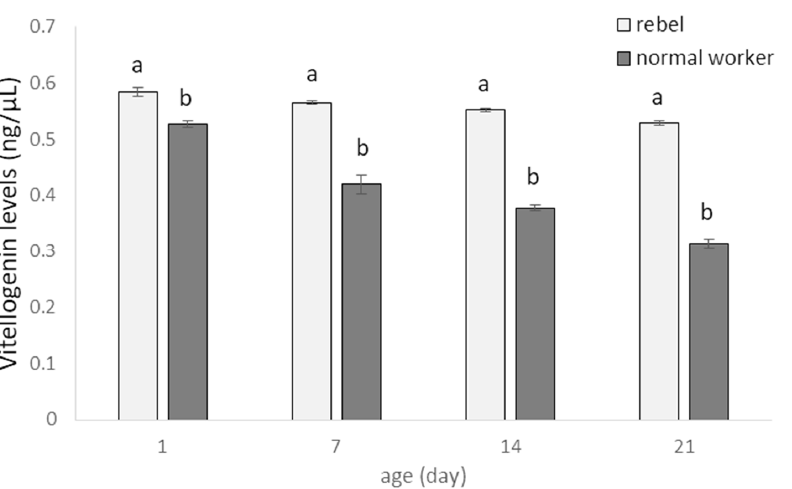
Figure 4. Vitellogenin levels (mean ± SD) in hemolymph of normal workers and rebels. Lowercase letters indicate significant differences between averages for the rebels and normal workers within a specific age with p < 0.01; No. of rebels = 60; no. of normal workers = 60. The numbers of oenocytes in the fat body of all segments (the fourth, fifth, sixth, and seventh tergite segments and in the sternite) increased with age of the workers and was always higher in rebels (Figure 5; Two-way ANOVA with multiple comparison testing using the post hoc Tukey HSD test; for the third tergite: age F (3,232) = 1080.2; p < 0.0001; castes/sub-caste F (1,232) = 25,095.0; p < 0.0001, post-hoc for each group max. p < 0.0001; castes/sub-caste*age F (2,232) = 1080.2, p < 0,0001, post-hoc for each group max. p = 0.01; for the fourth tergite: age F (3,232) = 28,103.0; p < 0,0001; castes/sub-caste F (1,232) = 27,218.0; p < 0.0001; post-hoc for each group max. p < 0.0001; castes/sub-caste*age F (3,232) = 1381.2; p <